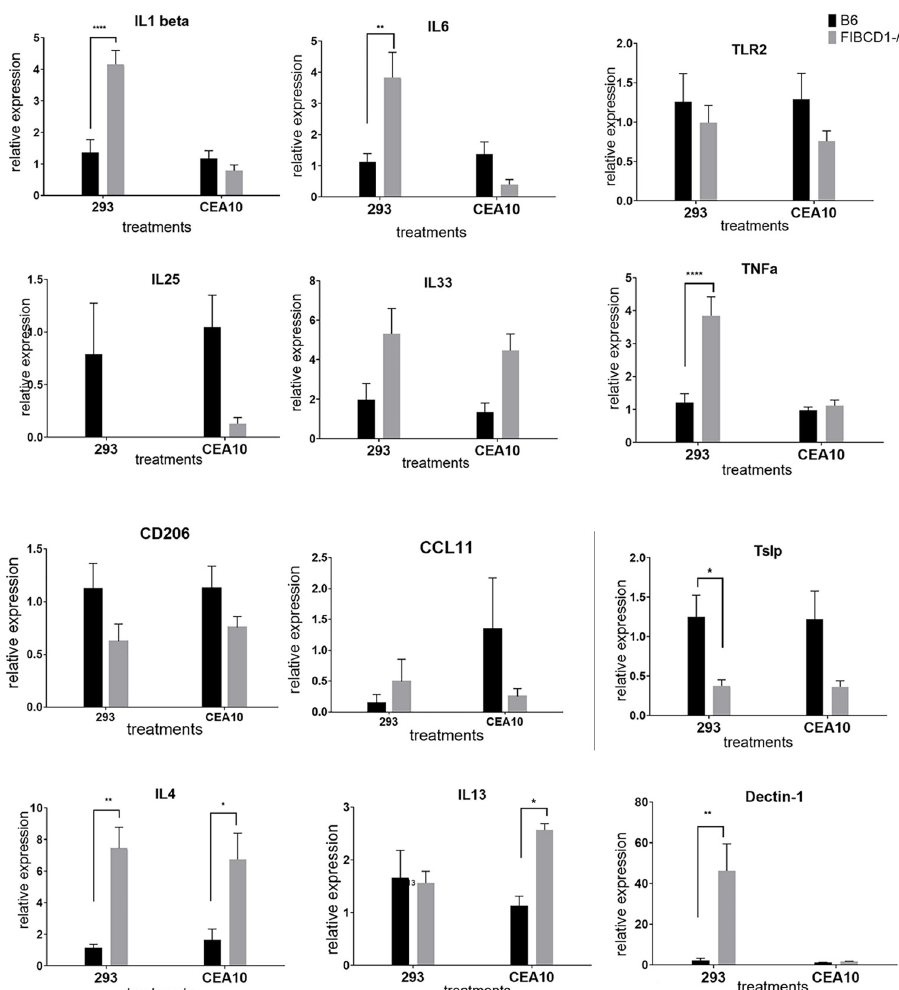
Fig 5. Cytokine modulation in vivo due to FIBCD1 in response to different strains of Aspergillus fumigatus . Mice were challenged with high dose of fungal conidia (as described in materials and methods).and samples are analyzed by qRT-PCR for expression of indicated cytokines using ΔΔ Ct method. Data are a summary of two experiments. n = 8/ group. � p < 0.05, �� p < 0.01, ��� p < 0.001, ���� p < 0.0001.